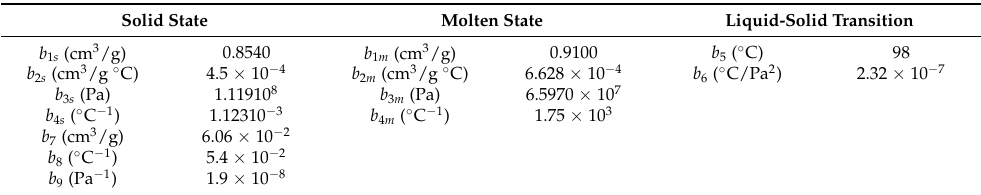
Table 5. Two-domain Tait equation estimated parameters of the PHBH polymer PVT experimental data obtained in isobaric cooling at 5 ◦ C/min.